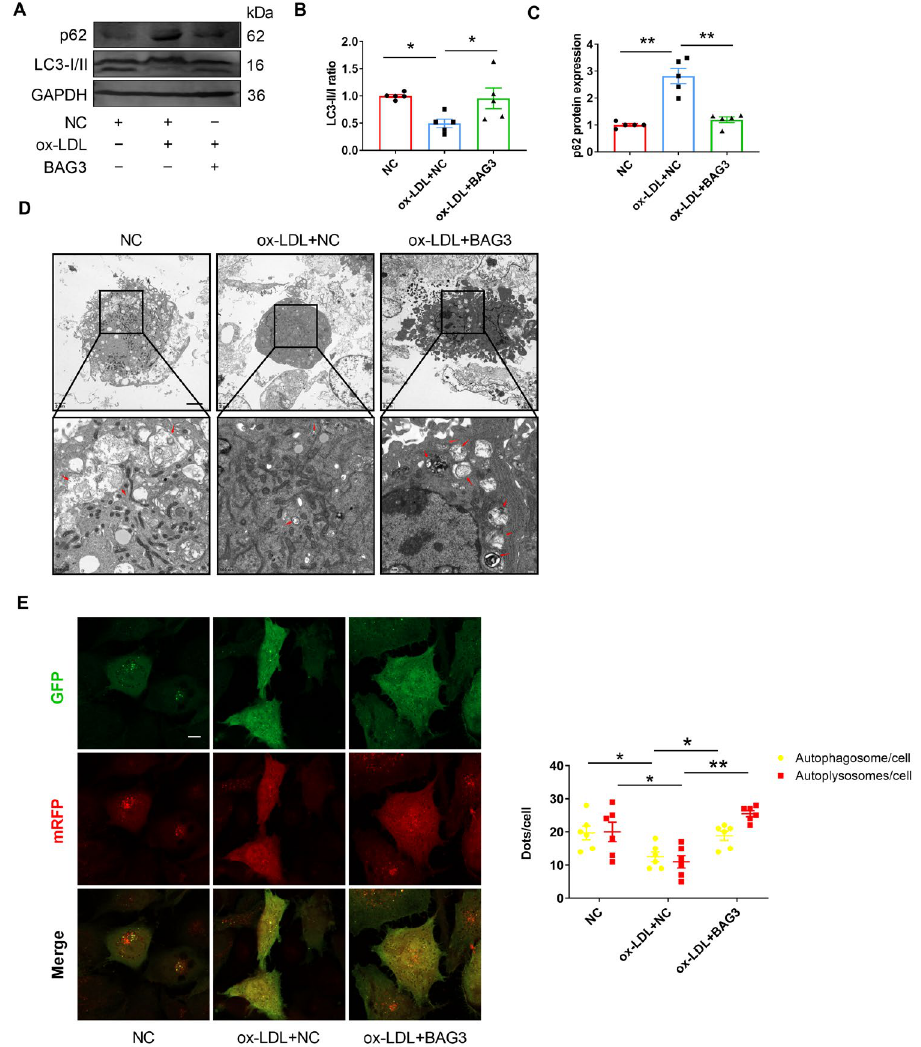
Figure 3. BAG3 positively regulates autophagy in HUVECs. ( A – C ) The LC3-II/LC3-I ratio and p62 protein expressions were detected using Western blotting. Fold changes are shown ( n = 5). ( D ) Elec- tron micrographs of HUVECs submitted to the indicated treatments, including autophagosomes and autolysosomes (red arrow) (scale bar indicates 2 µ m and 500 nm) ( n = 3). ( E ) Representative images and quantification of GFP-mRFP-LC3II puncta in HUVECs. (scale bar indicates 25 µm) ( n = 5). The data are presented as the mean ± S.E.M. * p < 0.05, ** p < 0.01.